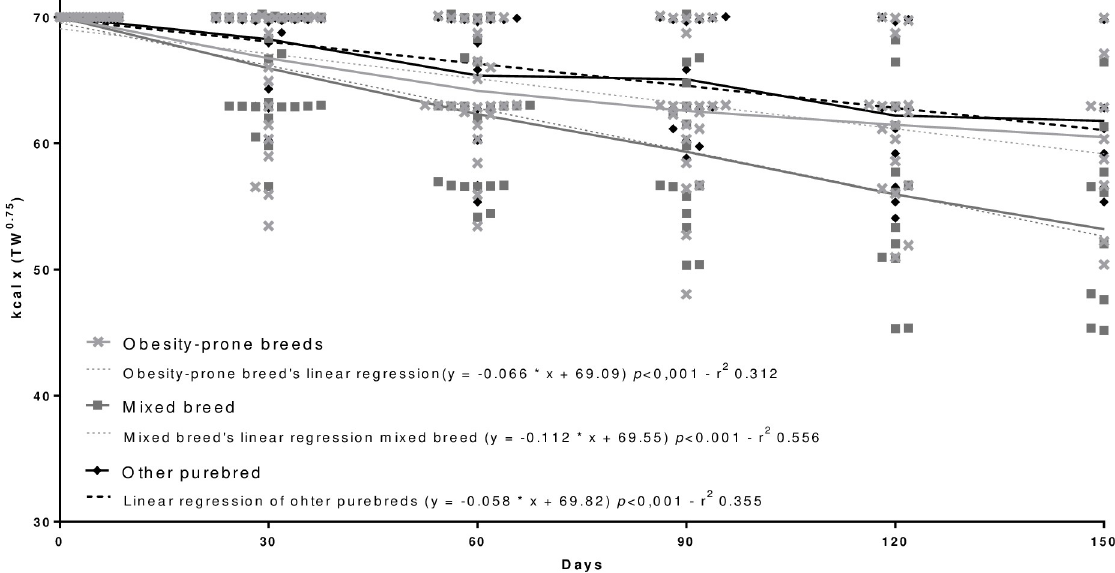
Fig 5. Regression analysis and complete distribution of the calories (kcal) applied to the weight loss equation [kcal x (TW 0.75 )] according with breed.